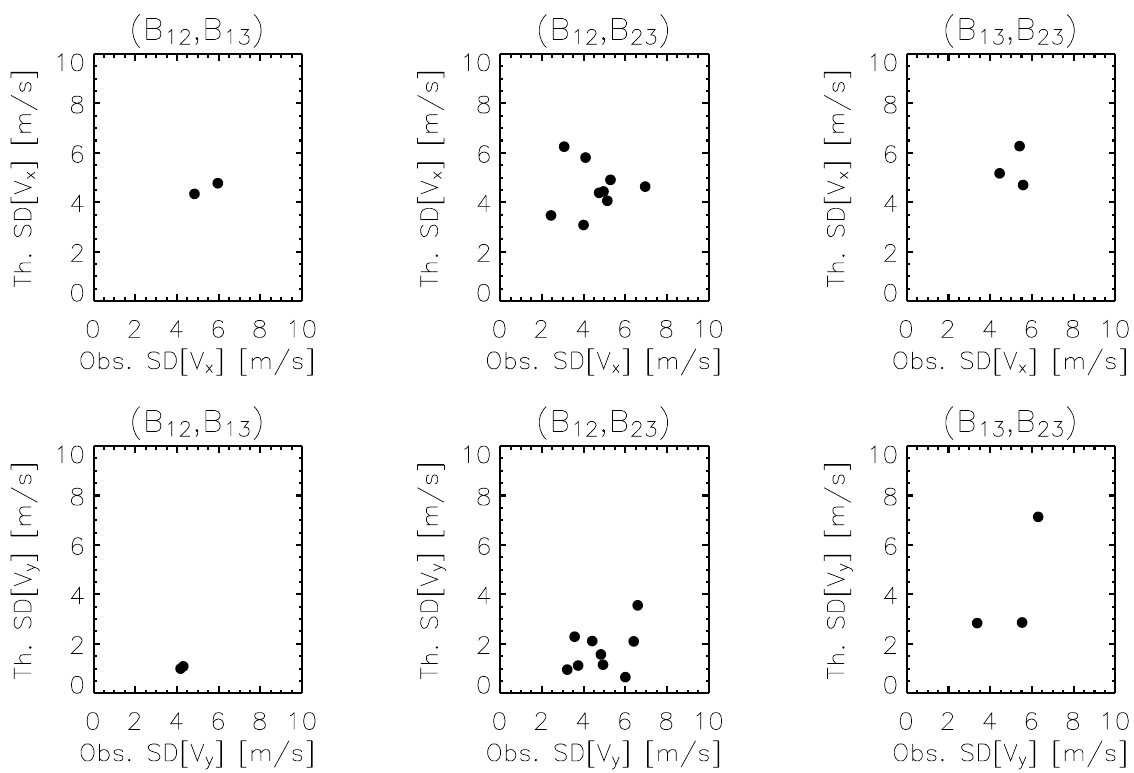
Fig. 5. A scatter plot showing the standard deviation (SD) of wind components from observation (Obs. SD) compared with theoretical calculations of the square root of the estimate variance (Th. SD), for different baseline pairs (see Fig. 2). Baseline pair ( B 12 , B 23 ) brackets the average wind direction and shows best results for both v x and v y